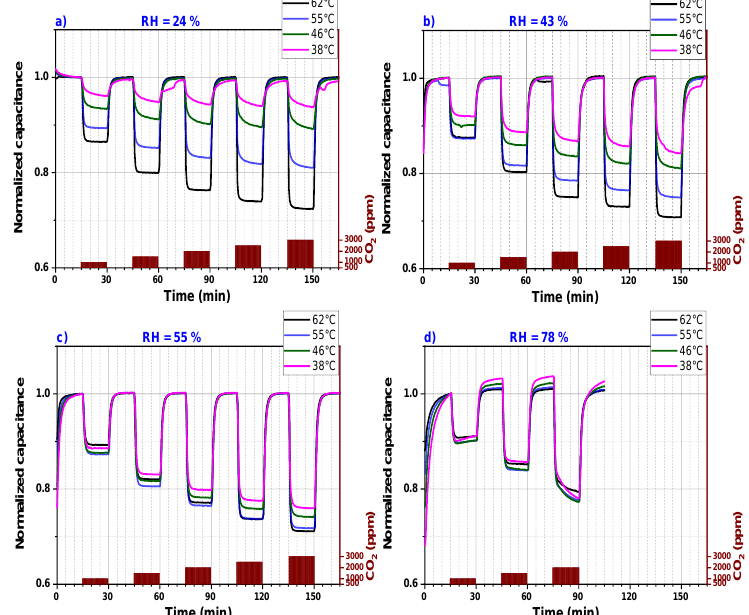
Figure 6. Capacitance (normalized to 1) versus sensing time of a PEI@silica-based CO 2 sensor at different operating temperatures and for different relative humidities: ( a ) 24% RH, ( b ) 43% RH, ( c ) 55% RH and ( d ) 78% RH.